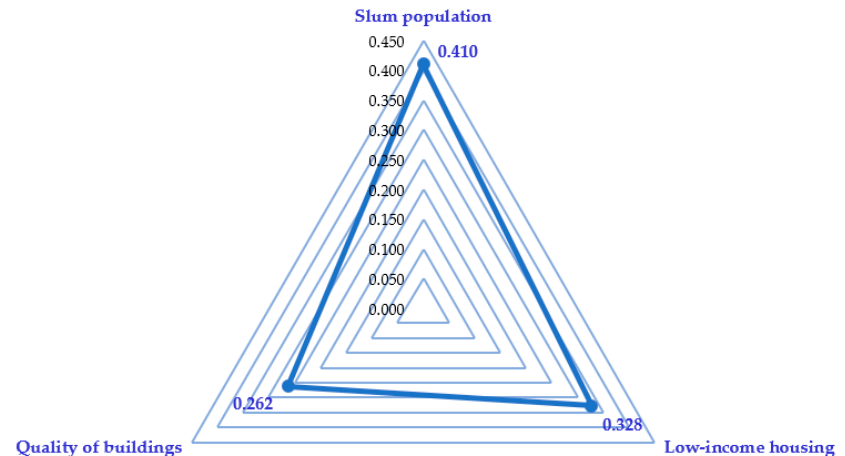
Figure 8. Relative weights of the assessment indicators for “Housing”.